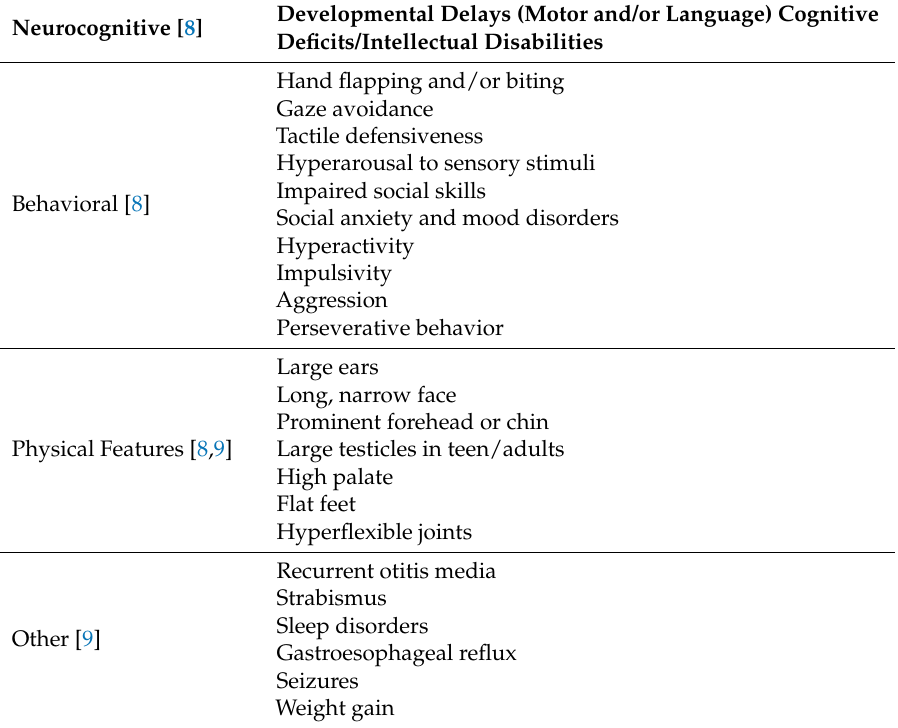
Table 1. Common features of fragile X syndrome